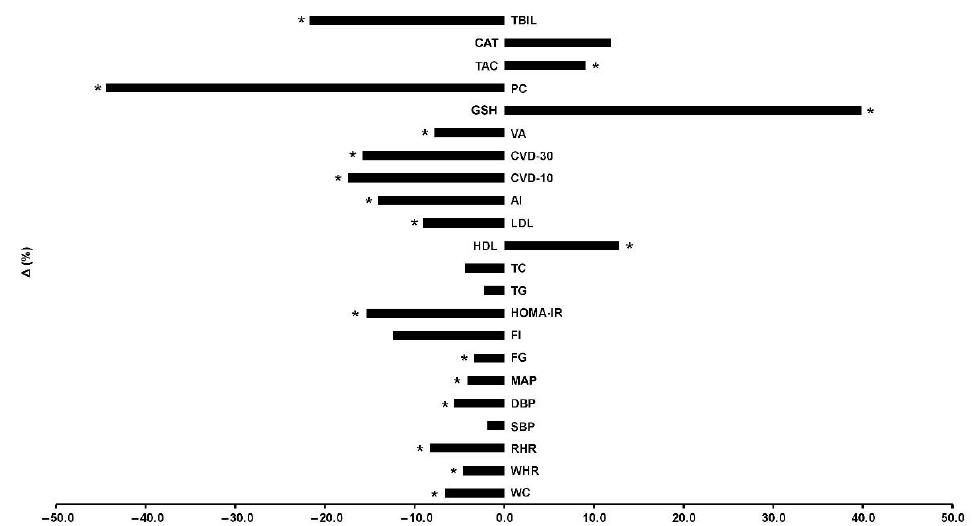
Figure 3. Percentage changes [Δ% = (Post – Pre)/Pre*100] in cardiometabolic health, redox status,